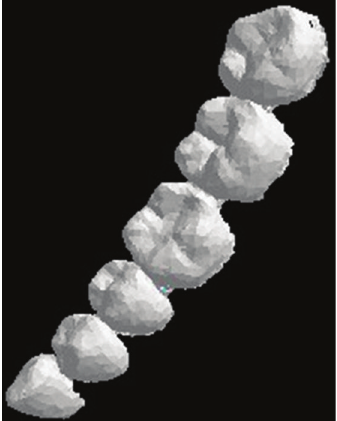
Figure 4: inEos Blue dental